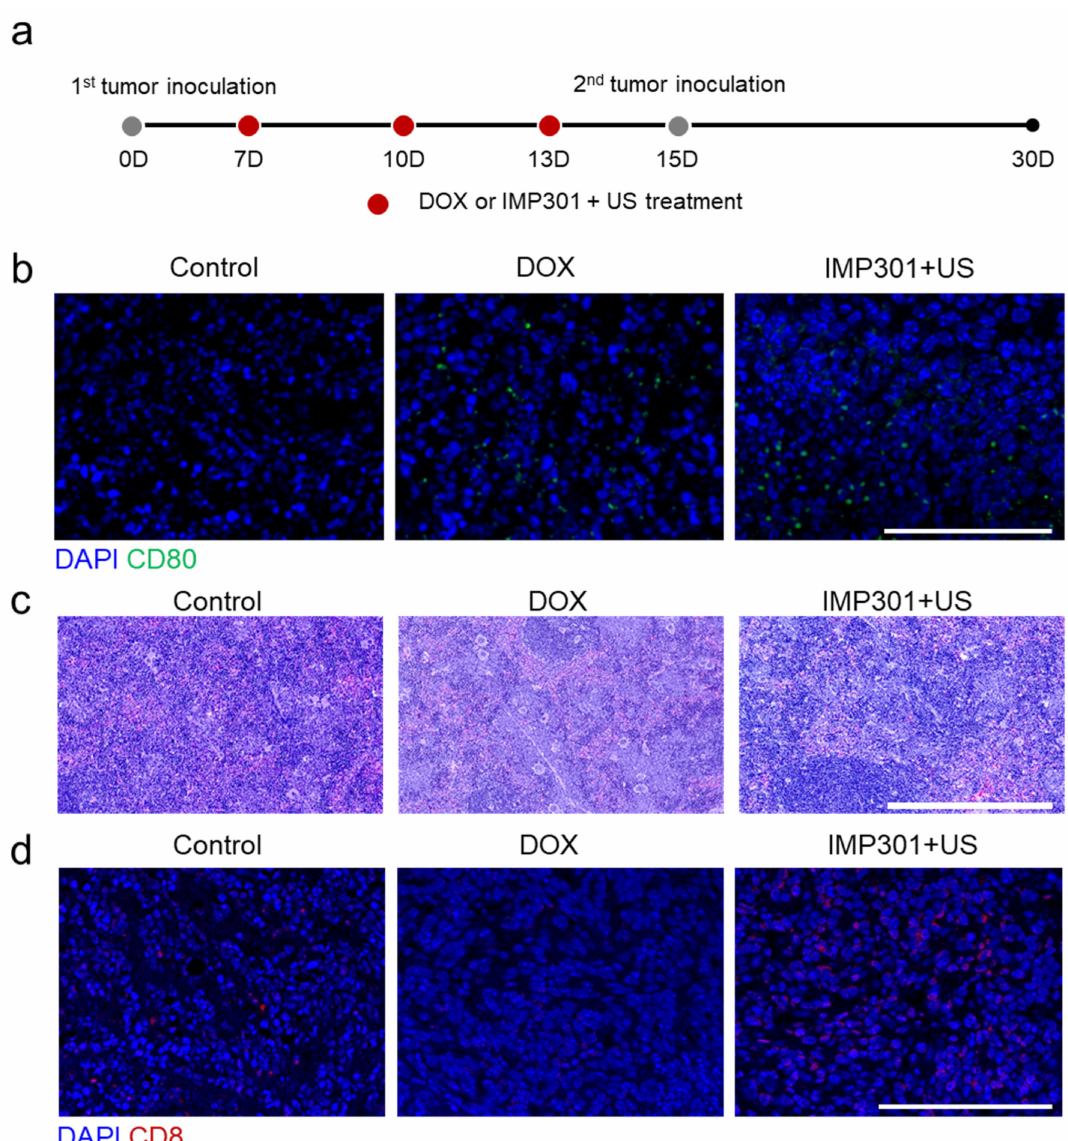
Figure 2. In vivo immunogenicity and systemic toxicity of the combination of IMP301 and US treat- ment. ( a ) Schematic illustration of the treatment protocol and ( b ) immunohistochemistry of mature APCs in tumor tissues. Blue: DAPI, Green: CD80. Scale bar represents 100 µ m. ( c ) Hematoxylin and eosin-stained spleen tissues. Scale bar represents 500 µ m. ( d ) Immunohistochemistry of infiltrated CTLs in tumor tissues. Blue: DAPI, Green: CD8. Scale bar represents 100 µ